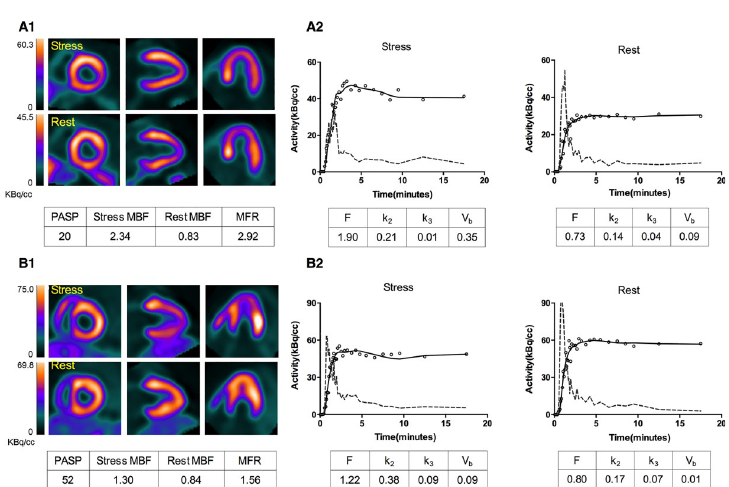
Fig 1. Representative cases of HCM with or without PH. (A1, B1): patient A is a 56-year-old female with normal PASP showing no evidence of vasodilator stress-induced myocardial ischemia; patient B is a 37-year-old female with elevated PASP revealing global myocardial ischemia but most severe in mid to apical regions of lateral and anterior walls; Lines from left to right: short axial slice; vertical axial slice; horizontal axial slice; (A2, B2): Time-activity curves at stress and rest. Dashed line: arterial blood; Hollow dots: myocardial time-activity curve of apical-lateral segment measured by PET; Solid line: myocardial time-activity curve predicted by the model.